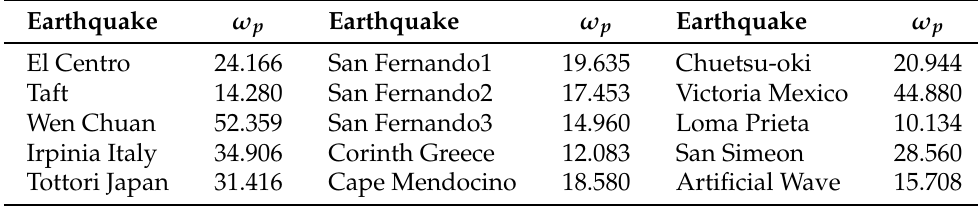
Table 3. Peak frequency of response spectrum (rad/s).